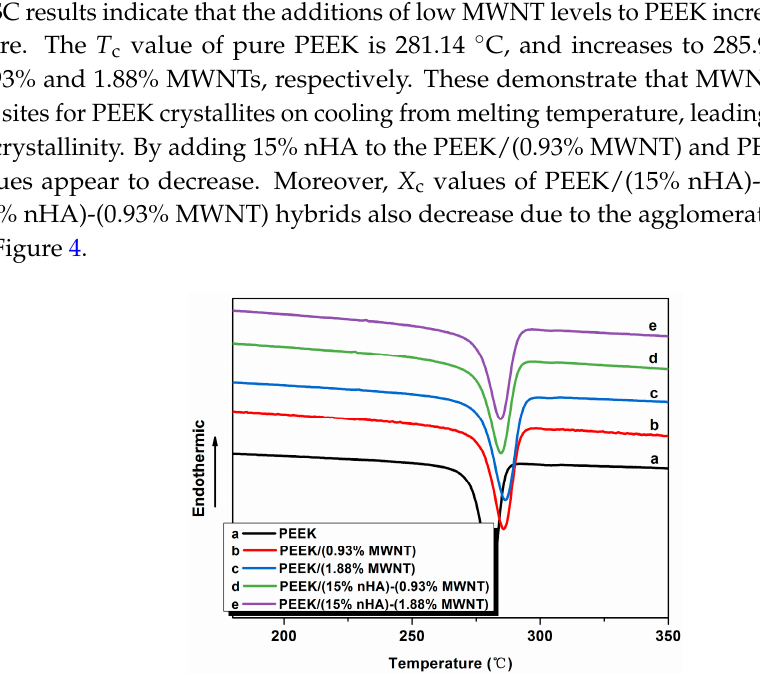
Figure 4. Differential scanning calorimetry (DSC) cooling curves of PEEK and its nanocomposites. Table 2. Crystallization parameters of PEEK and its nanocomposites.